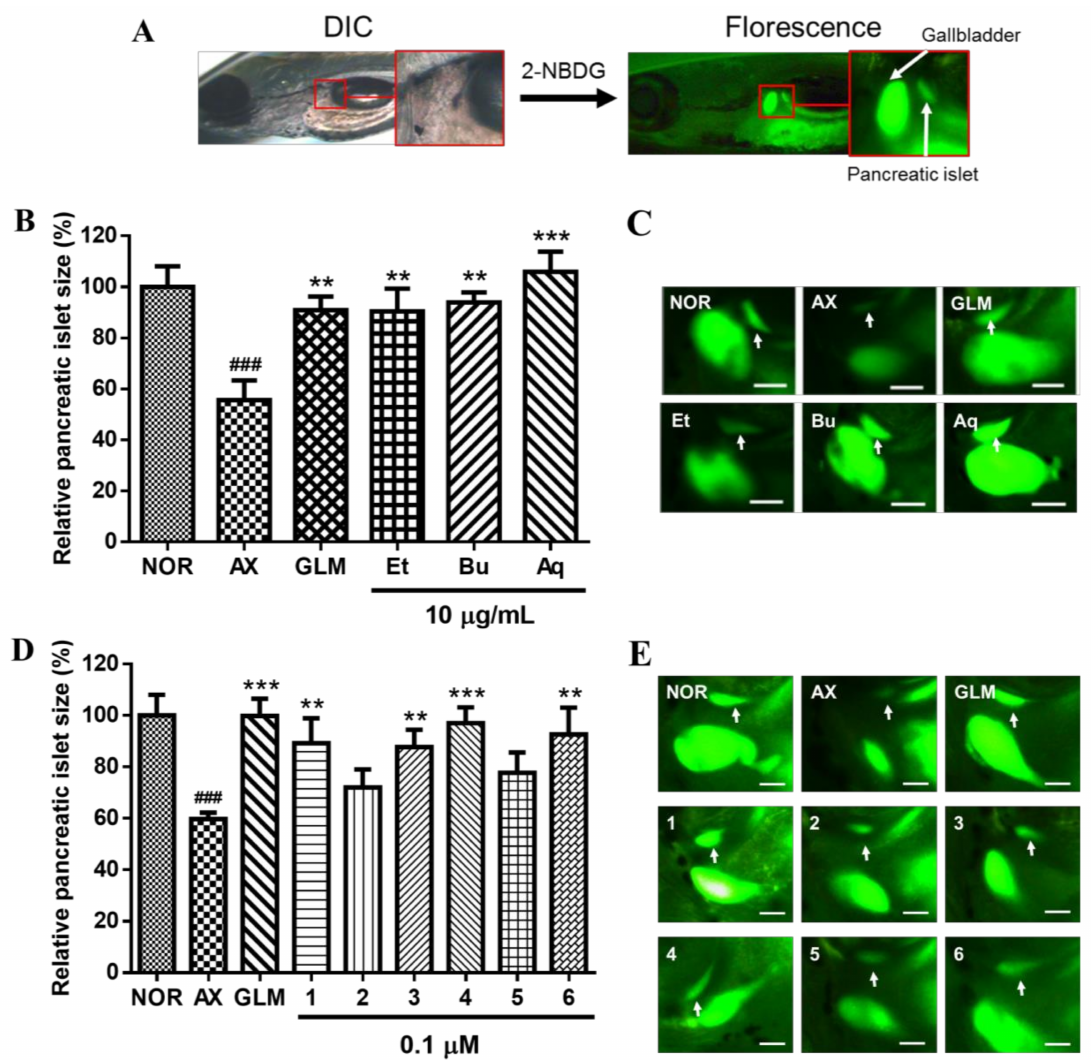
Figure 3. Changes in pancreatic islet (PI) area and fluorescence intensity caused by 2-NBDG. ( A ) The PI sizes of wild-type zebrafish and zebrafish larvae at 5 days post-fertilization (dpf) were evaluated by differential interference contrast (DIC) and fluorescence microscopy. ( B ) Changes in PI size caused in each fraction were analyzed with Focus Lite software. NOR: normal group, AX: alloxan-induced group, GLM: glimepiride, Et: EtOAc fraction, Bu: n -BuOH fraction, Aq: aqueous fraction. ( ### p < 0.001; compared to NOR), (** p < 0.01, *** p < 0.001; compared to AX). ( C ) Fluorescent microscopic images of PIs treated with each fraction following treatment with 2-NBDG at 10 µ g/mL. ( D ) Changes in PI